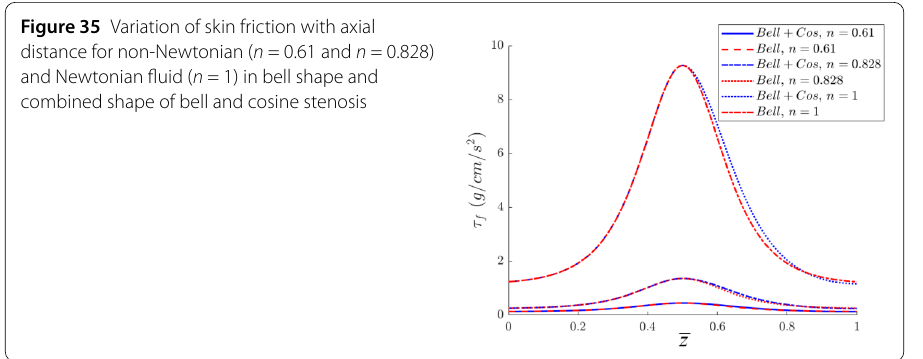
Figure 35 Variation of skin friction with axial distance for non-Newtonian ( n = 0.61 and n = 0.828) and Newtonian fluid ( n = 1) in bell shape and combined shape of bell and cosine